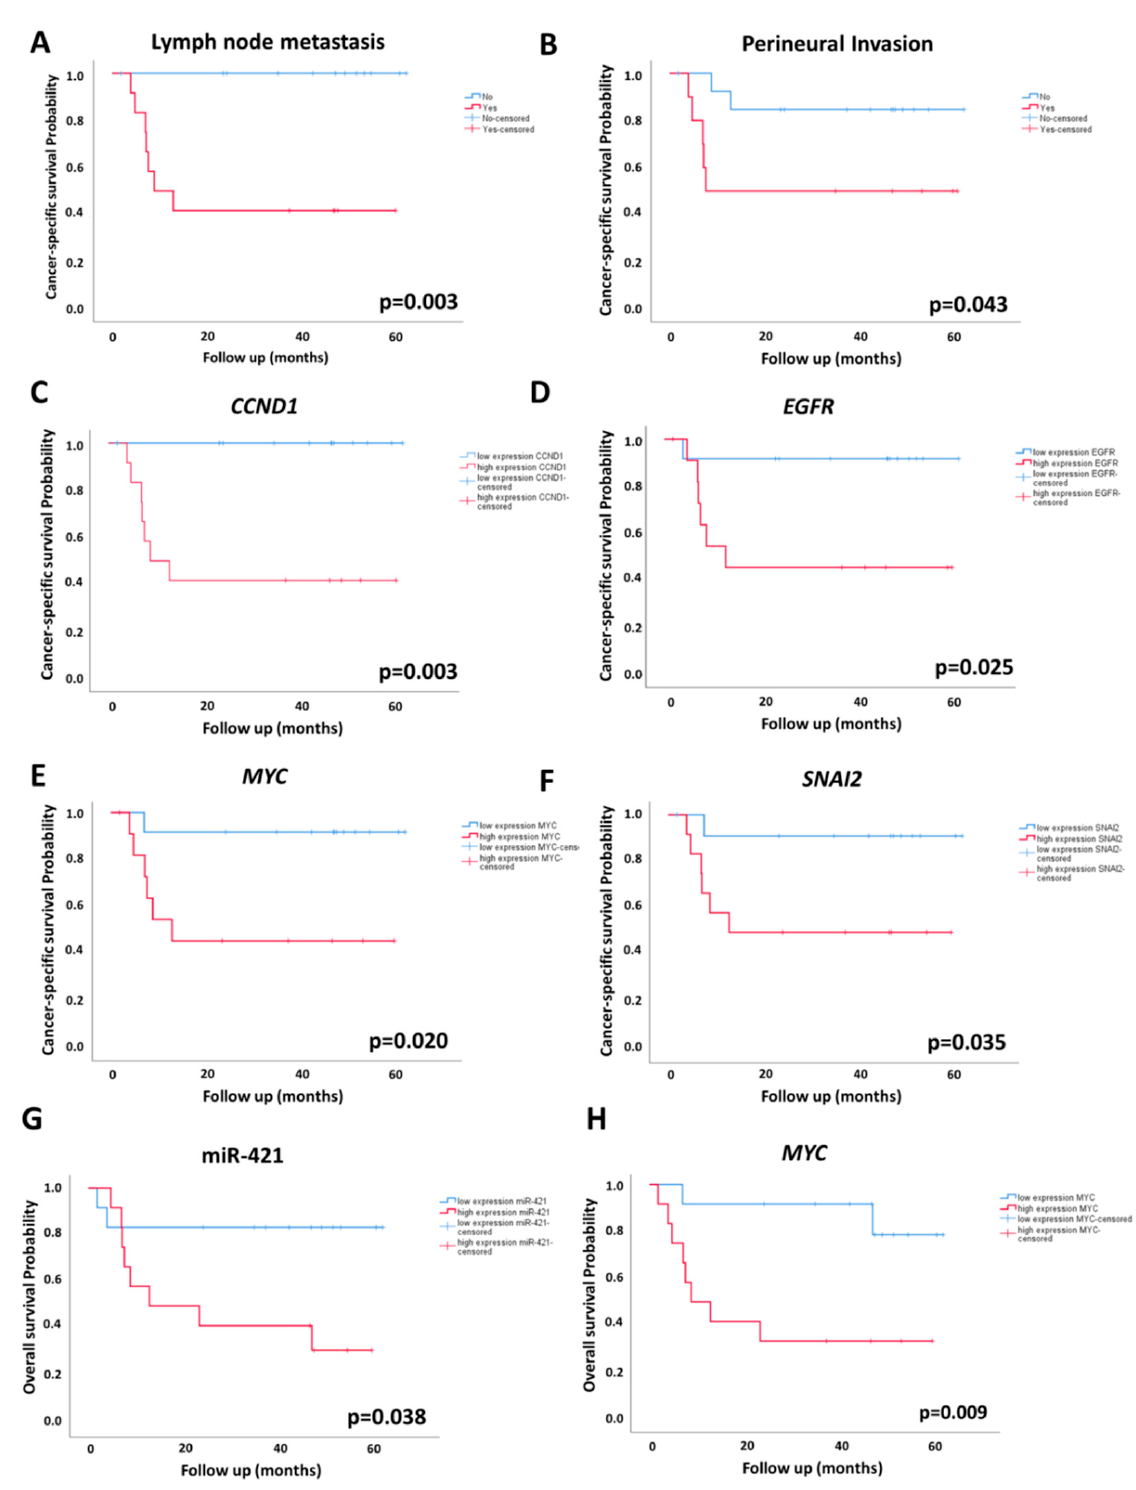
Figure 2. Cancer-specific survival (CSS) ( A – F ) and overall survival (OS) ( G , H ) analyses of PeC patients according to the clinicopathological variables and miRNA/gene expression patterns. Kaplan–Meier curves show that the presence of lymph node metastasis ( A ) and perineural invasion ( B ) were associated with worse CSS; High expression (defined as values above the -dCT median expression) of CCND1 ( C ), EGFR ( D ), MYC ( E ), and SNAI2 ( F ) were associated with shorter CSS; miR-421 ( G ) and MYC ( H ) were associated with shorter OS.